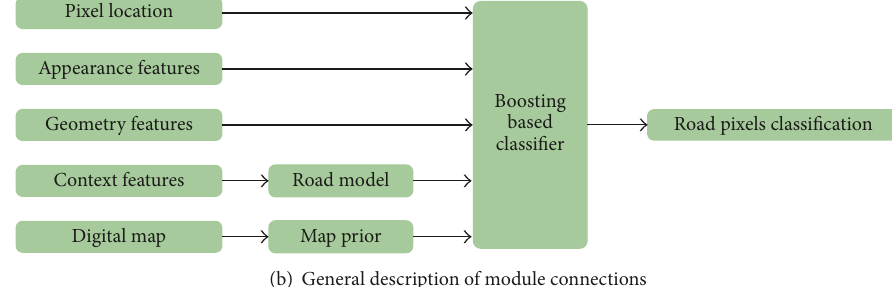
Figure 2: Features classification based on the sensor and general architecture of the proposed